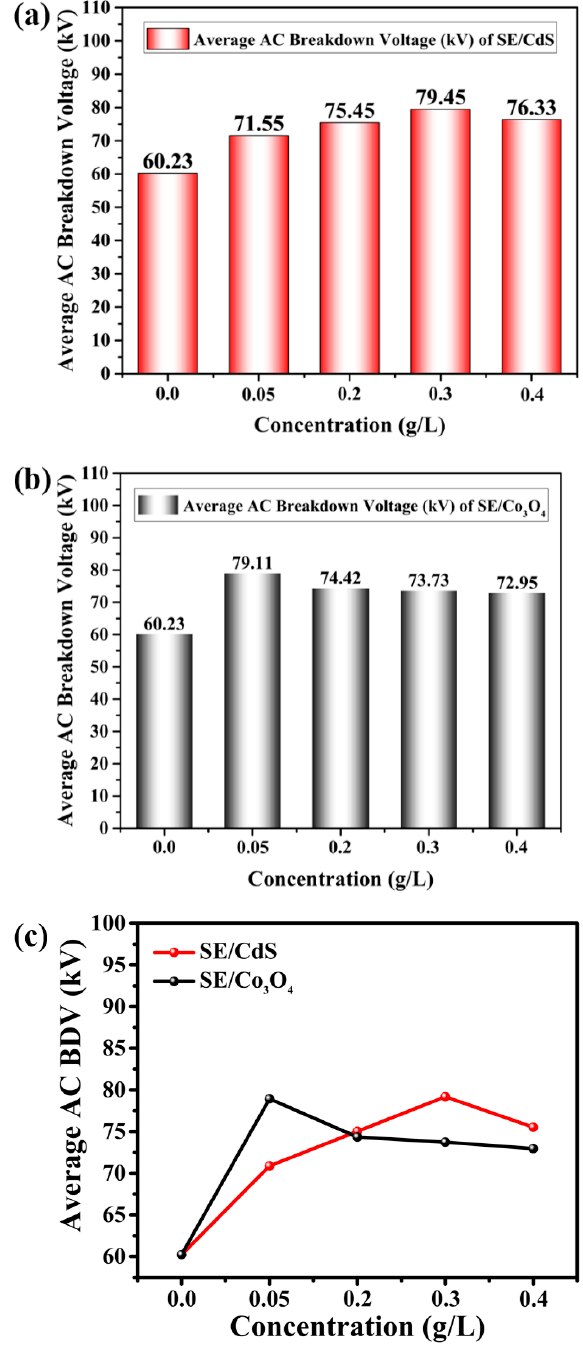
Figure 4. Average AC breakdown voltage (kV) of ( a ) SE/CdS and ( b ) SE/Co 3 O 4 at different doping concentrations; ( c ) comparison of average AC breakdown voltage of nanofluids.